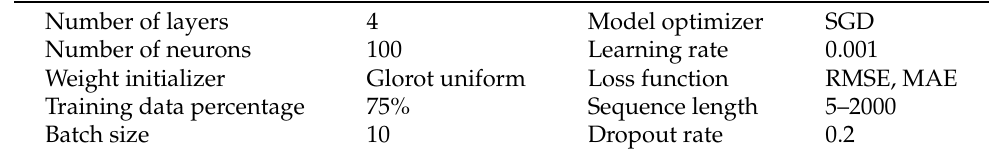
Table 2. Simulation parameters for training the proposed mobility